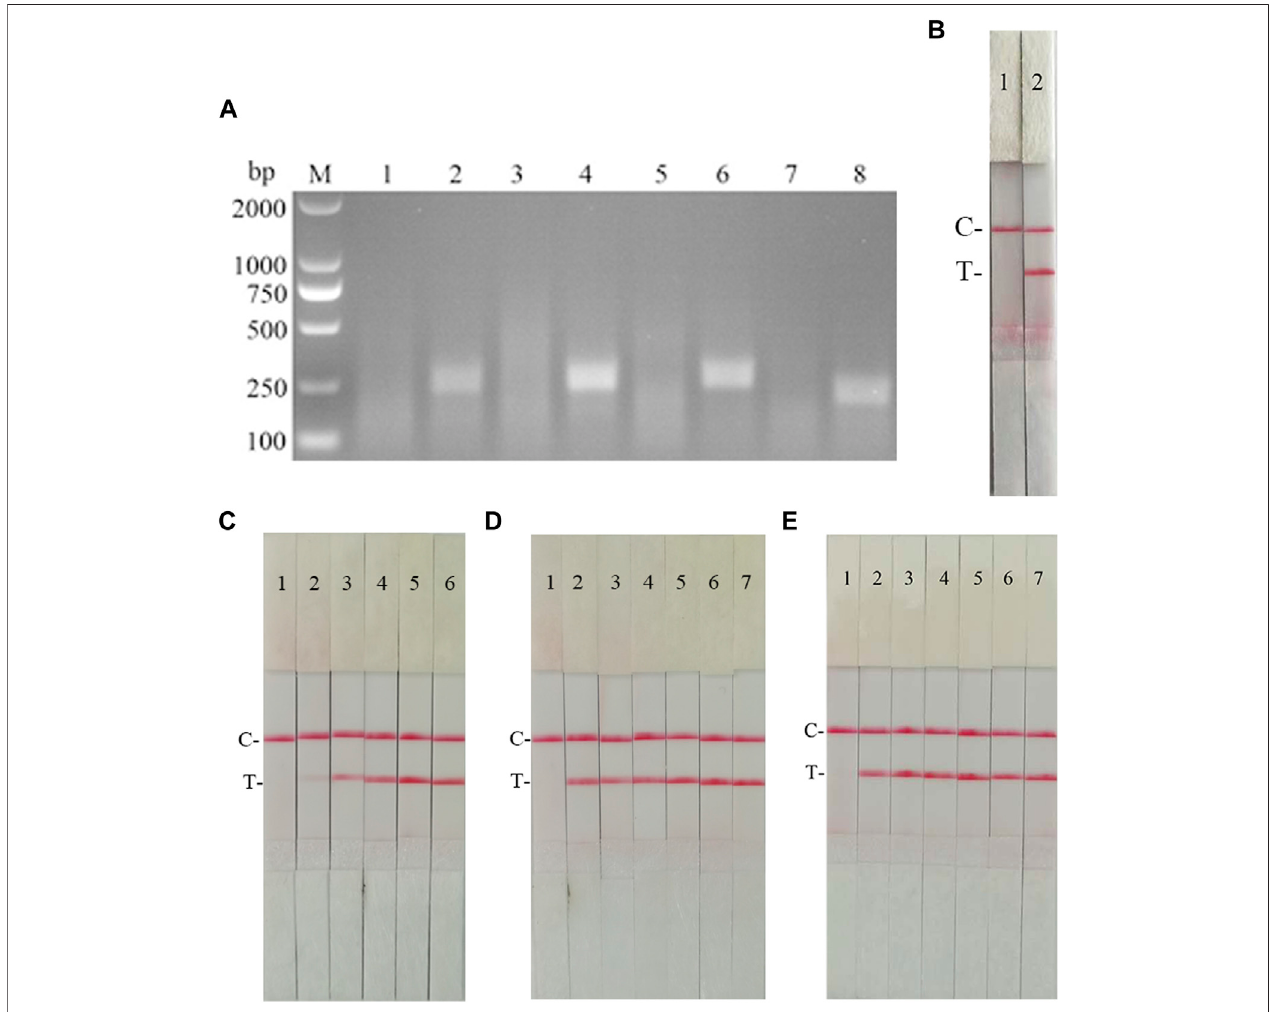
FIGURE7| EstablishmentofCSFV RAA-Strip and Optimization oftheReactionCondition. (A) Optimal primer selection. Misa2,000 bpDNA marker. Theprimers and templates used in lane 1 – 8 successively are: CSFV-RAA-F1/R1+ddH 2 O, CSFV-RAA-F1/R1+CSFV, CSFV-RAA-F2/R2+ddH 2 O, CSFV-RAA-F2/R2+CSFV, CSFV- RAA-F3/R3+ddH 2 O, CSFV-RAA-F3/R3+CSFV, CSFV-RAA-F4/R4+ddH 2 O, and CSFV-RAA-F4/R4+CSFV. (B) Initial development of the CSFV RAA nucleic acid strip assay.UsingtherecombinantplasmidpMD19-T-NS5BasatemplatetotesttheCSFVRAA-strip.Cisacontrolline.Tisatestline.Thetemplatesusedinlane1and 2 successively are the negative control and the CSFV pMD19-T-NS5B. (C) The determination of the optimal reaction temperature range of CSFV RAA-strip. The temperature of templates used in lane 2 – 6 successively are 25, 30, 35, 40, and 45 ° C. (D) The detection of the accurate optimal temperature. The temperature of templates used in lane 2 – 7 successively are 35, 36, 37, 38, 39, and 40 ° C. (E) Optimization of reaction time. Using the recombinant plasmid pMD19-T-NS5B as a templatetooptimizetheampli fi cationtimeofCSFVRAA-strip.Line1isanegativecontrol.Thereactiontimeoftemplatesusedinlanes2 – 7successivelyare5,10,15,20, 25 and 30